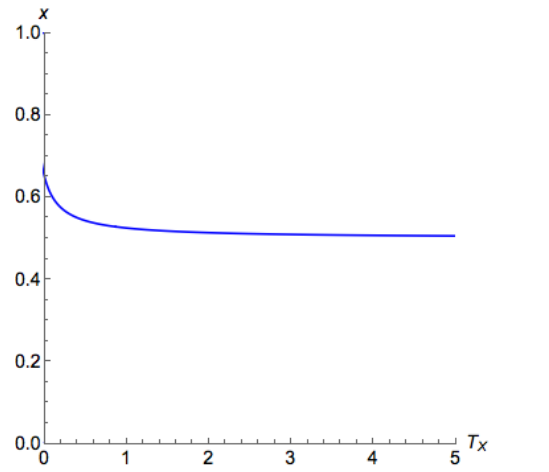
Figure A1. Bifurcation diagram for a game with no dominating strategy for the first player, a Y + b Y < 0, and a low T Y .